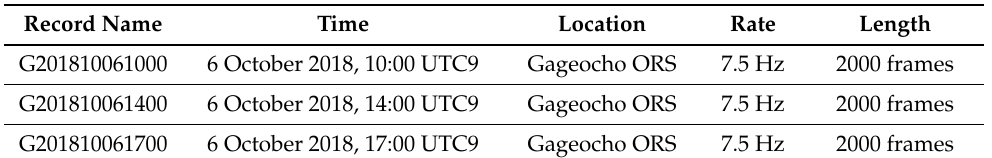
Table 2. The three stereo sequences used to compare the two WASSfast reconstruction modes against the old WASS pipeline.